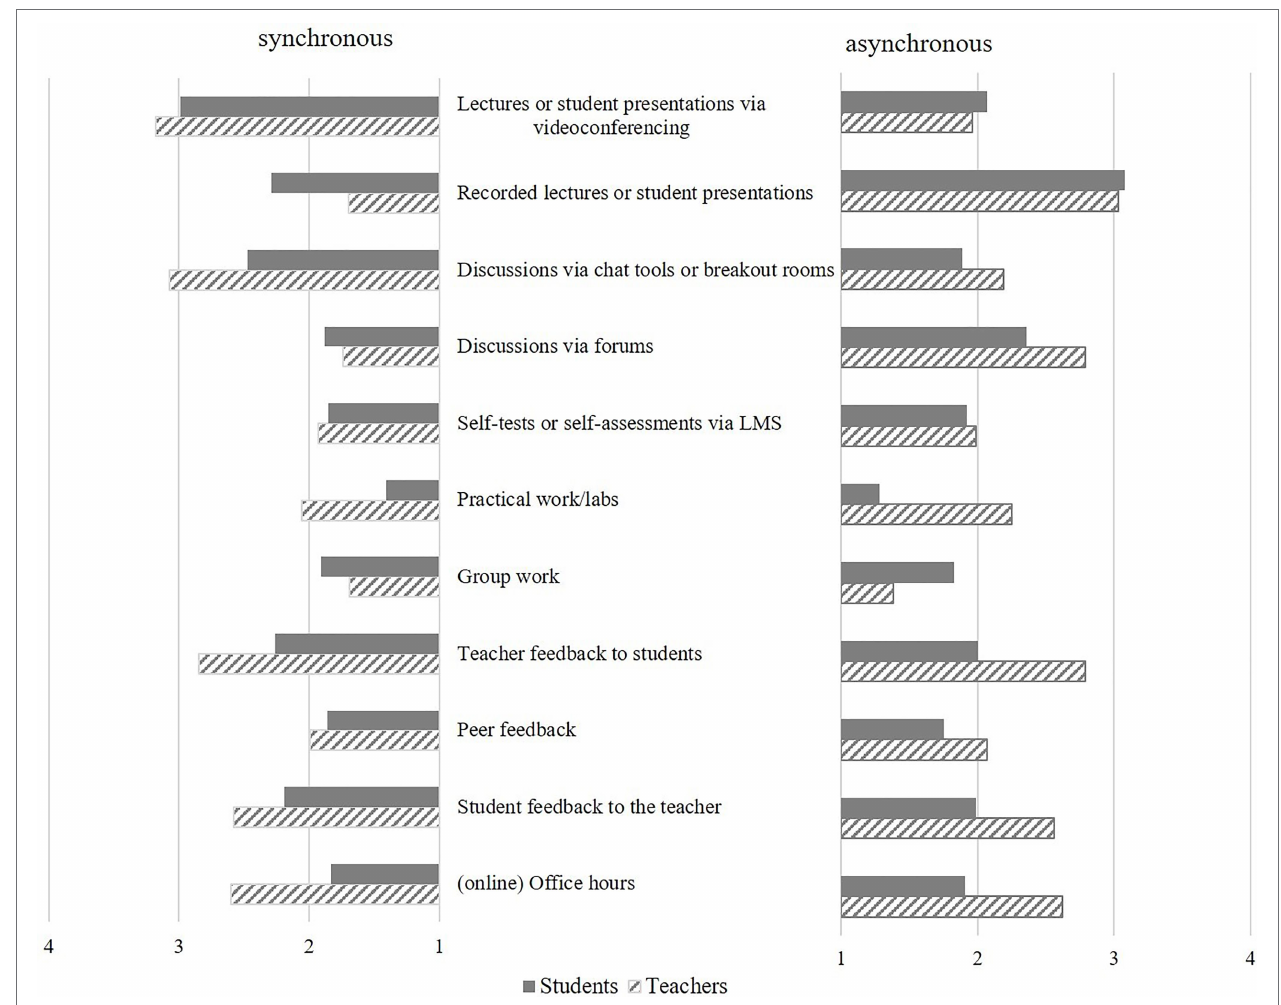
FIGURE 1 | Reported mean frequencies of teaching and learning methods (1 = never to 4 = very frequent ) in synchronous vs. asynchronous settings by students and